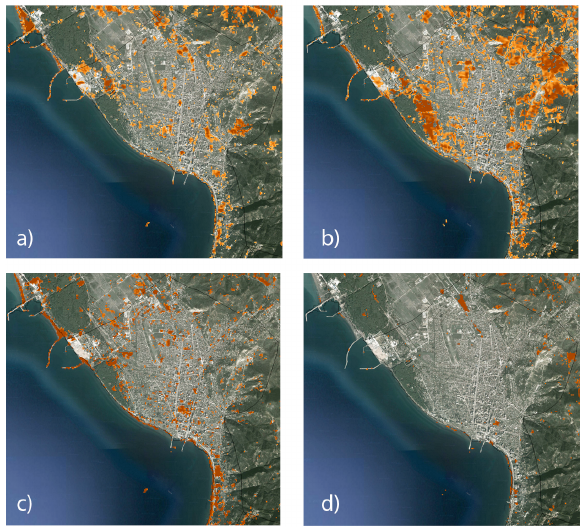
Figure 3. Changes of the urban areas through time in the city of (a), 1991-2000 (b), 2001-2010 (c) and 2011-2015 (d).